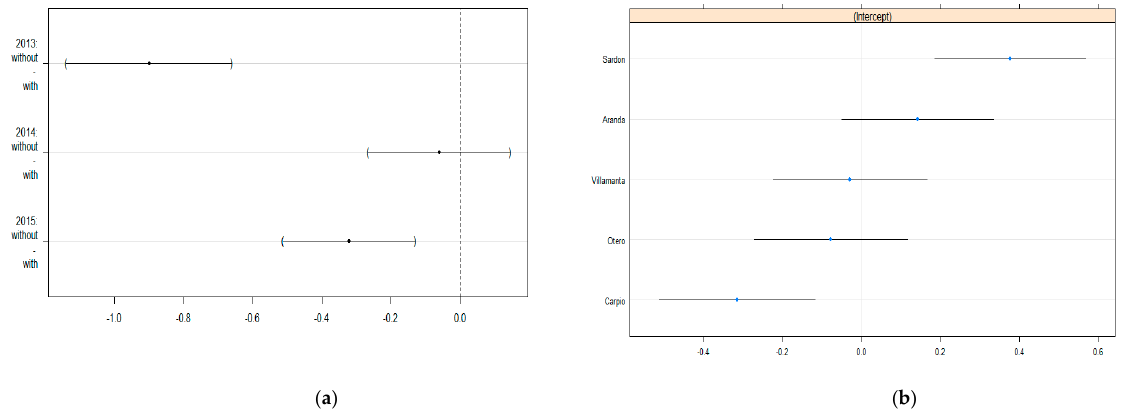
Figure 4. Ninety-five percent confidence intervals for the fixed and random effects of the fitted negative binomial GLMM; ( a ) 95% confidence intervals for Tukey multiple comparisons between zones through years; ( b ) 95% confidence intervals for the random intercepts of the farms.